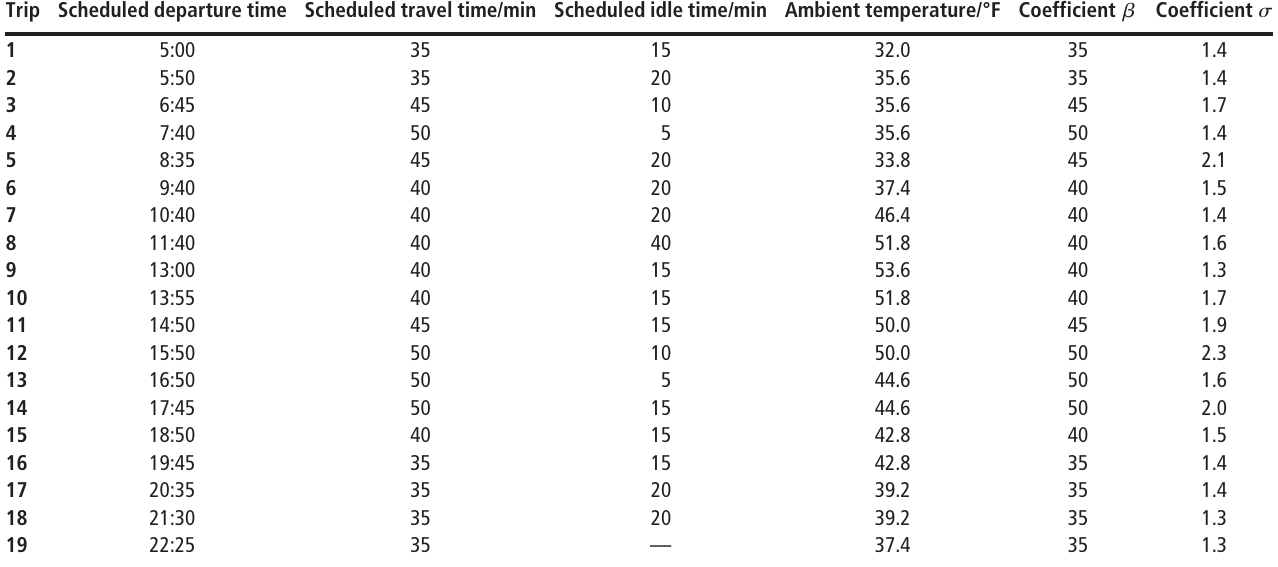
Table 3 Departure timetable of the electric